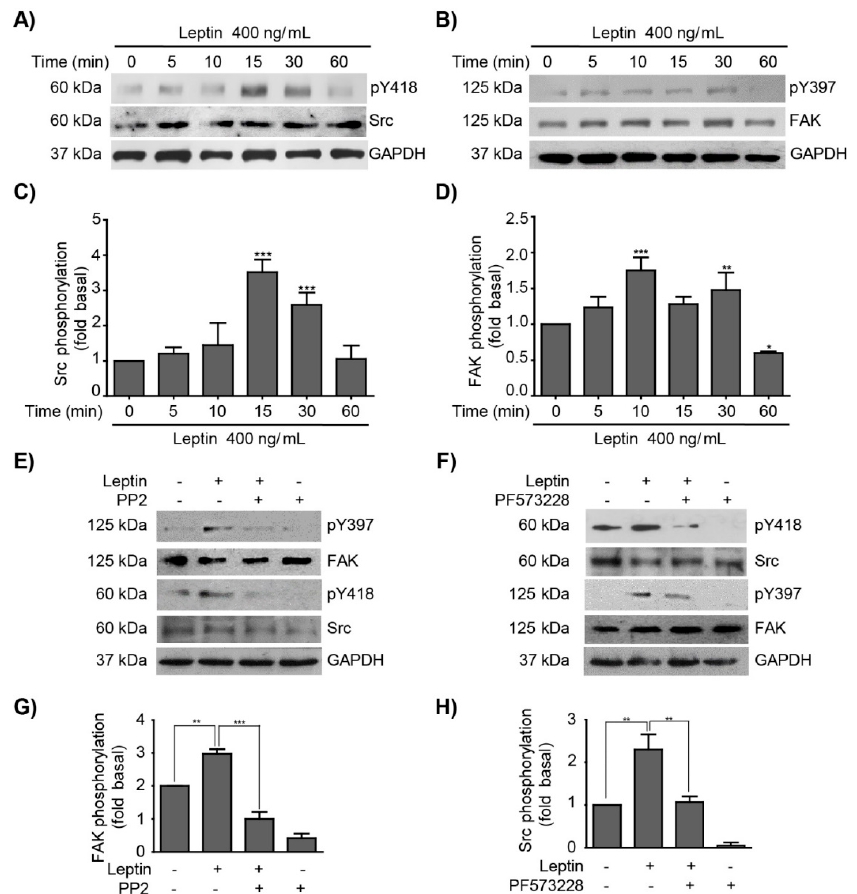
Figure 1. Leptin activates Src and FAK in the non-tumorigenic breast epithelial cell line MCF10A. Representative Western blots of whole cell extracts obtained at different time points from MCF10A cells stimulated with 400 ng/mL of leptin. ( A ) Effect of leptin in Src activation was detected with an anti-p-Y418 antibody and was compared to total Src. ( B ) Effect of leptin in FAK activation was detected with an anti-p-Y397 antibody and was compared to total FAK. GAPDH was used as loading control. Densitometric analyses of ( C ) Src, and ( D ) FAK phosphorylation dependent on leptin. MCF10A cells were pre-treated with Src (PP2) or FAK (PF-573228) inhibitors, and subsequently with leptin 400 ng/mL. Representative western blots of Src phosphorylated in Y418 ( E ), and FAK phosphorylated in Y397 ( F ). Control blots showing loss of pY418-Src and pY397-FAK in the presence of inhibitors, PP2 and PF573228 are shown. GAPDH was used as a loading control. Densitometric analyses of leptin-dependent ( G ) FAK, and ( H ) Src phosphorylation in the presence of the inhibitors. The values are shown in means ± SD of three independent experiments and are expressed as changes with respect to the control (unstimulated cells). The asterisks indicate the comparison made with respect to the control. * p < 0.05, ** p < 0.01 and *** p <0.001 by one-way ANOVA (Dunnett´s and Newman-Keuls´s test).